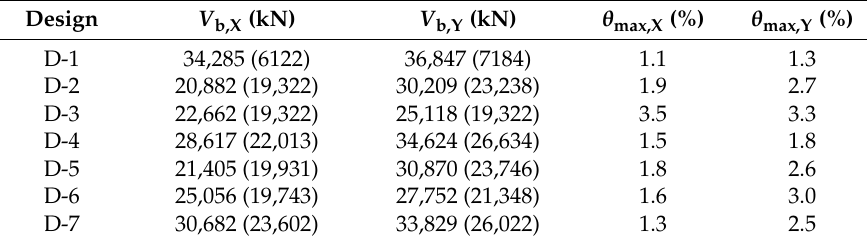
Table 3. Results from response spectrum analysis.